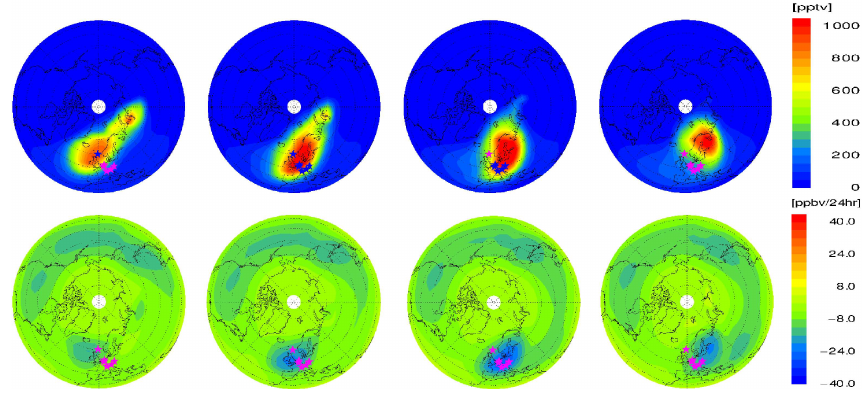
Fig. 12. ClO x (top row) and over 24h cumulated chemical ozone change (bottom row) as simulated by KASIMA for 17 to 20 January 2006, 12:00UT, for the 23.5km height level (around 2 = 500K); the six sounding stations are marked by stars (different colours for better